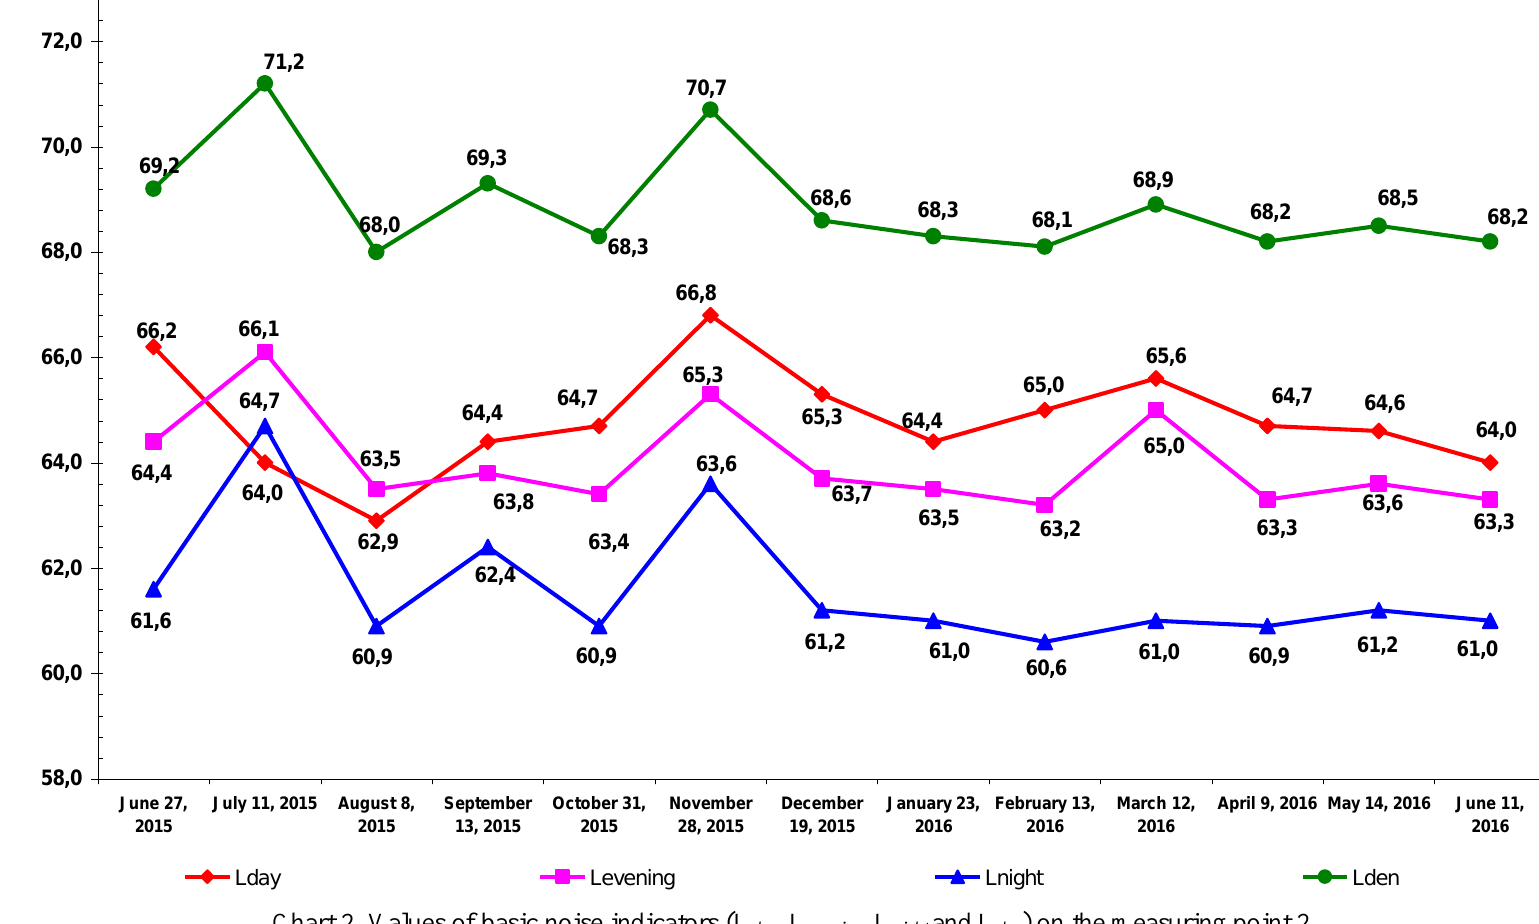
Chart 2. Values of basic noise indicators (L in the "zone of the city center and city roads" of the City of Novi Sad during the period 2012 −